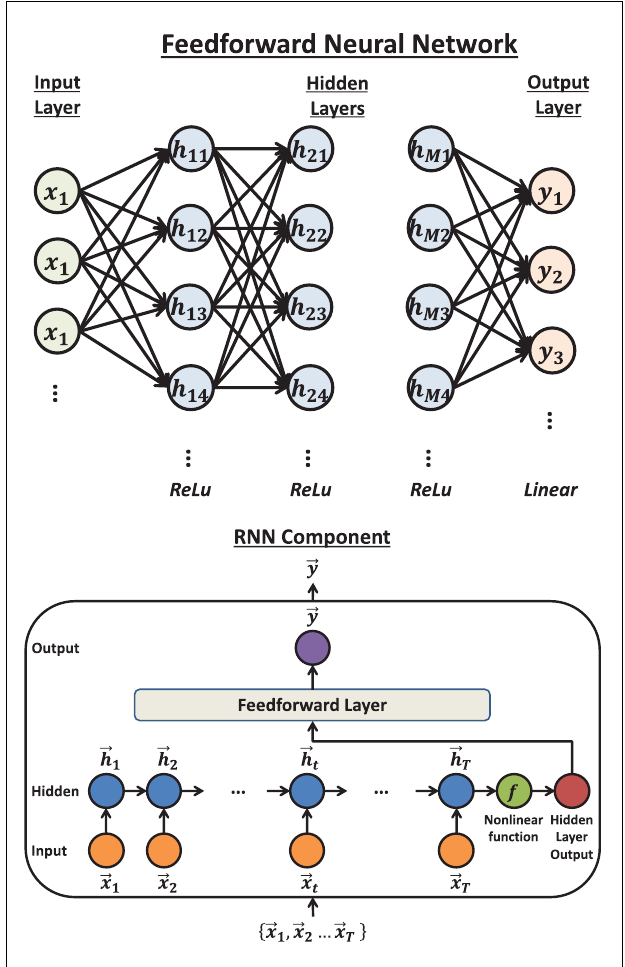
FIGURE 3 | The structure of feedforward neural network and Recurrent Neural Network (RNN): Top: The typical structure of a feedforward neural network. Each unit will calculate a weighted sum of the units in the previous layer that connect to it by an arrow. Then by adding an intercept term and transforming the value by an activation function, the unit obtains the value it sends out. Bottom: the structure of a Recurrent Neural Network component. The input vectors are connected by a chain hidden layer. Each hidden unit is the transformed value of the linear combination of the corresponding input unit and previous hidden unit. The last hidden unit value (vector) will be transformed by another non-linear function and sent to the dense layer to compute the